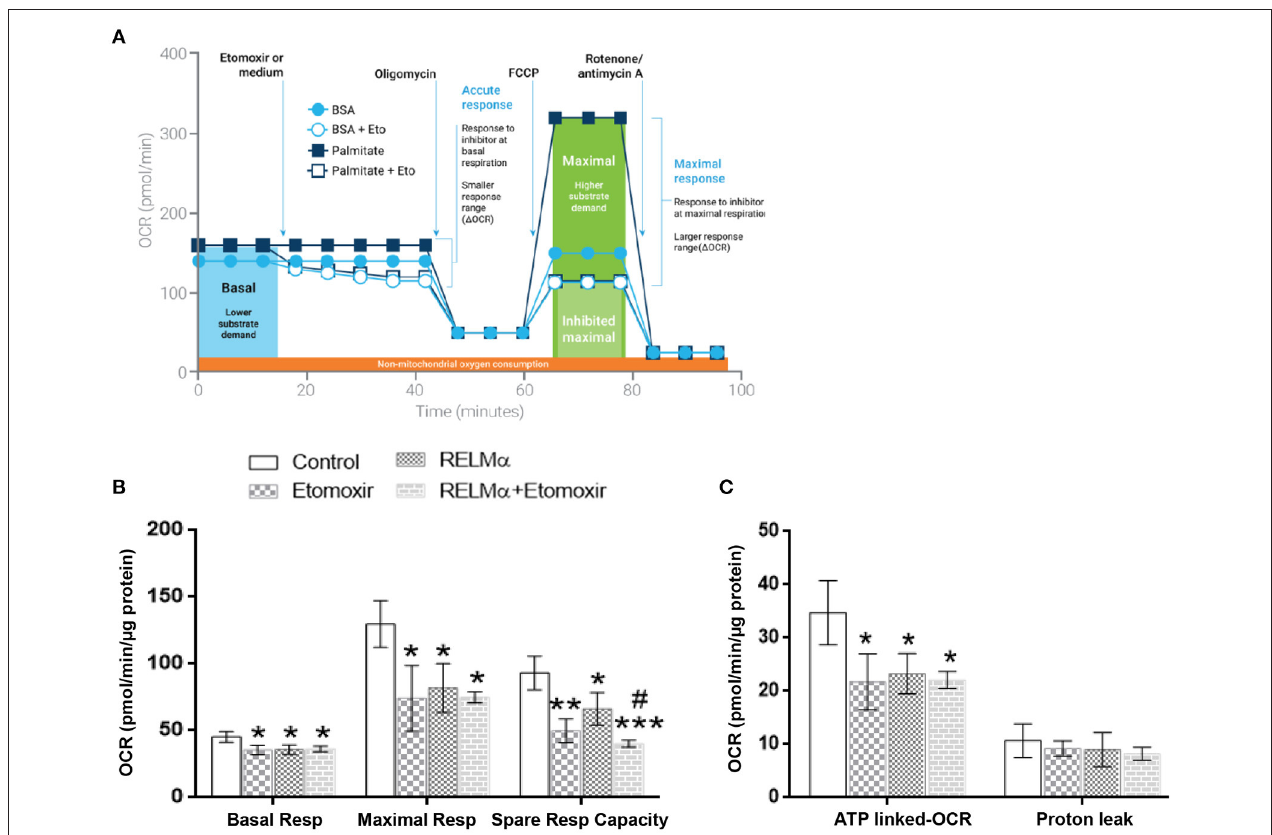
FIGURE 4 | Neonatal rat cardiomyocytes (NRCMs) challenged with RELM α or Etomoxir alone or in combination exhibit decreased OCR based mitochondrial bioenergetics. (A) Schematic representation of fatty acid oxidation assay with Etomoxir (courtesy Agilent Technologies) in presence of Palmitate-BSA as substrate to primary cultured cardiomyocytes. Cardiomyocytes were treated with either assay media and/or Etomoxir (final concentration 4 µ M,) as port A injection. After three baseline measurements, NRCMs were subjected to a final concentration of oligomycin (1 µ M), FCCP (2 µ M), and a combination of rotenone (0.5 µ M) and antimycin A (0.5 µ M) as ports B, C, and D injections, respectively, at the indicated times for assessment of basal mitochondrial respiration, maximal respiration, spare respiratory capacity, ATP-linked OCR, and proton leak. (B) Basal respiration, maximal respiration and spare respiratory capacity in cardiomyocytes treated with RELM α with or without Etomoxir. (C) OCR based ATP-linked OCR and proton leak in cardiomyocytes treated with RELM α with or without Etomoxir. n = 3 per group. *, **, *** p < 0.05, 0.01, 0.001 vs. control group. # p < 0.05 vs. RELM α